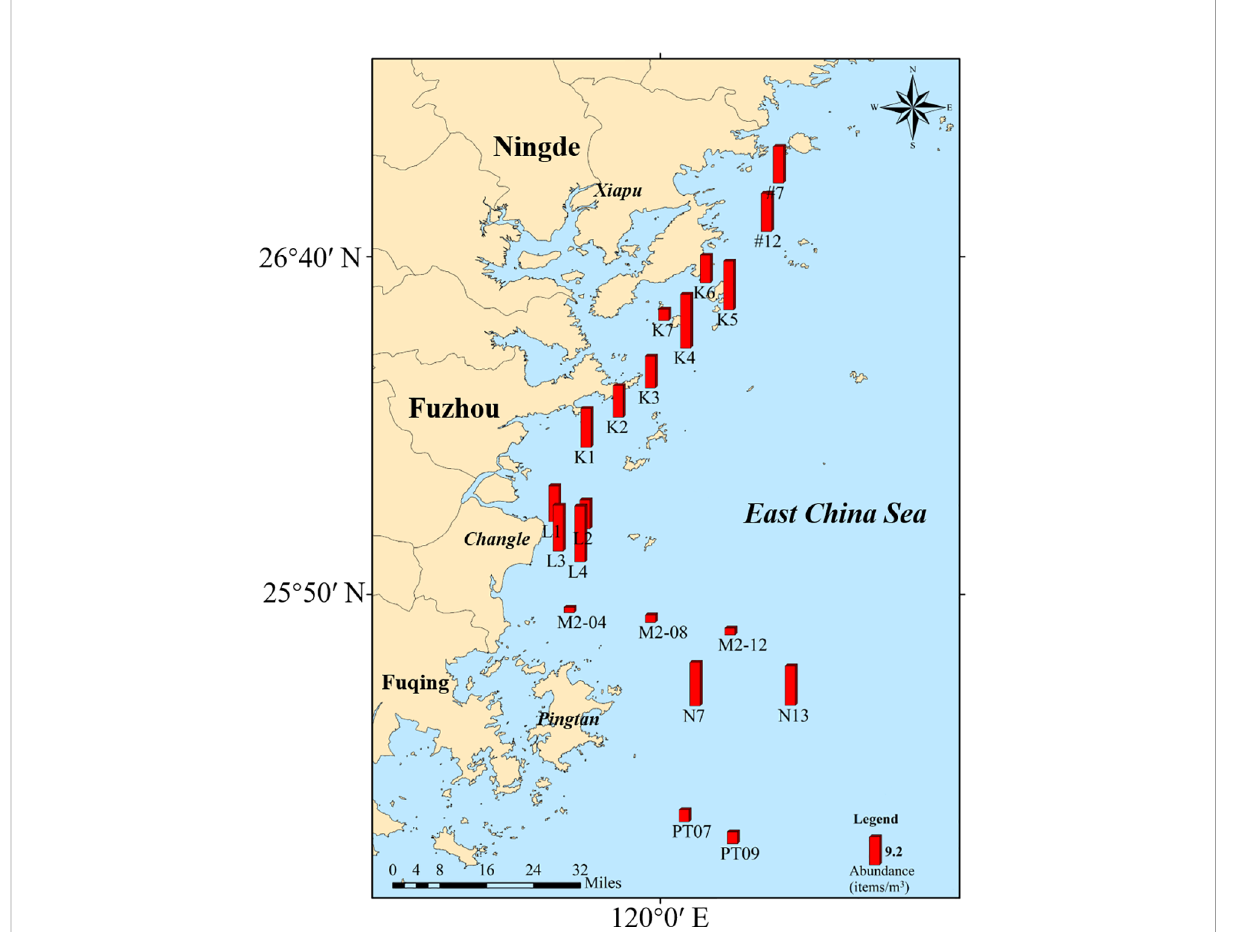
FIGURE 4 The abundance of MPs in the surface seawater along the Fujian coast of the East China